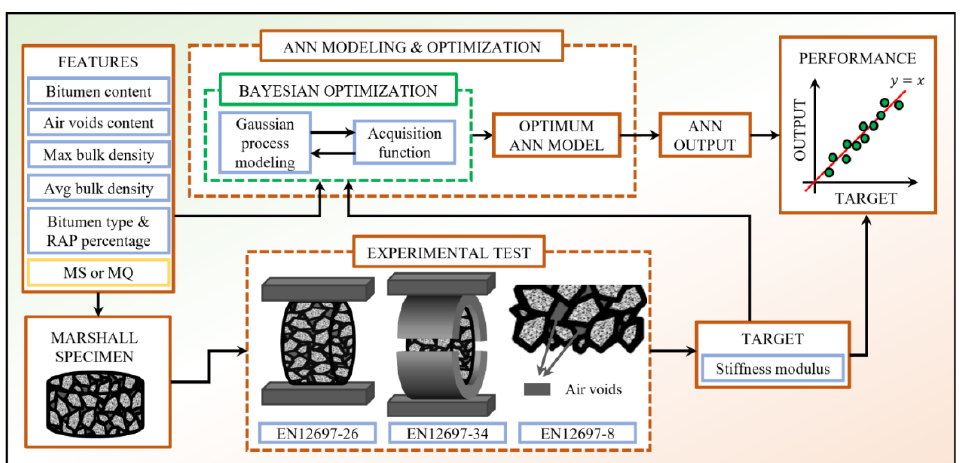
Figure 5. Step-by-step methodology applied in the current study setup.